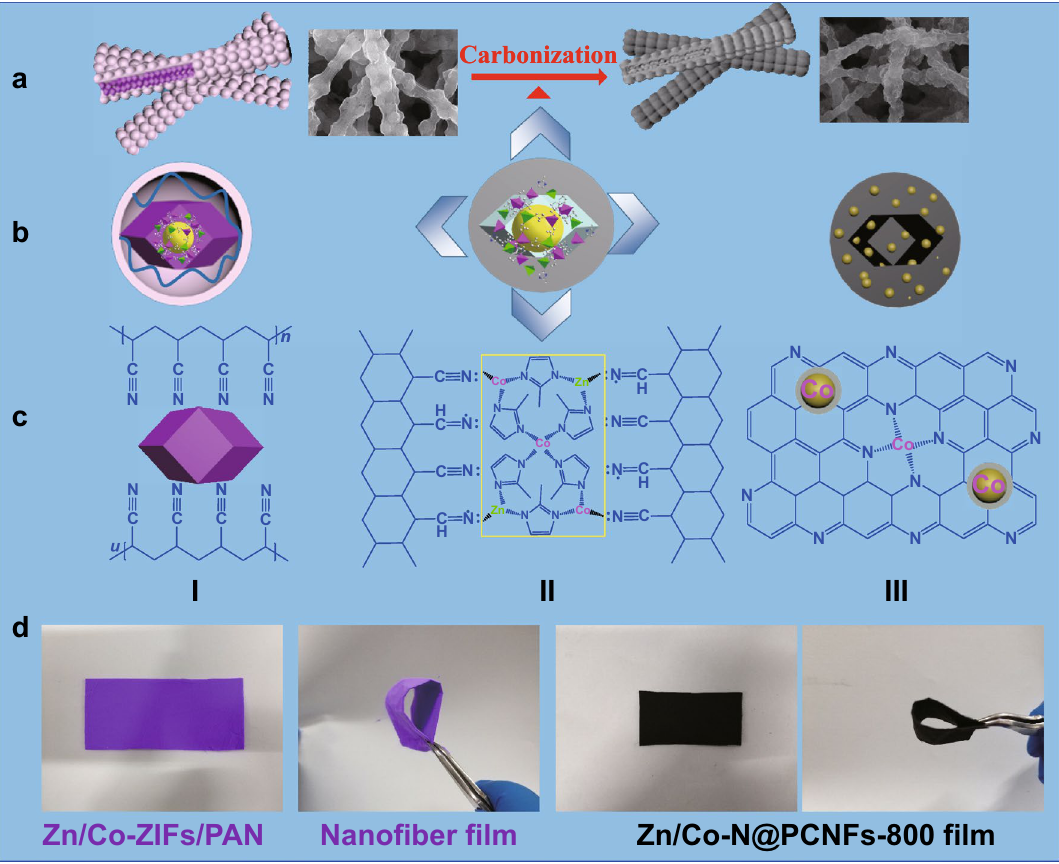
Fig. 1 Schematic illustration for the preparation of Zn/Co–N@PCNFs from electrospun Zn/Co-ZIFs/PAN nanofibers. a The micro-morphol- ogies of the nanofibers before and after carbonization. b The simulated cross section diagram. c The simulated molecular structure diagram. d The digital photographs of the nanofiber film before and after